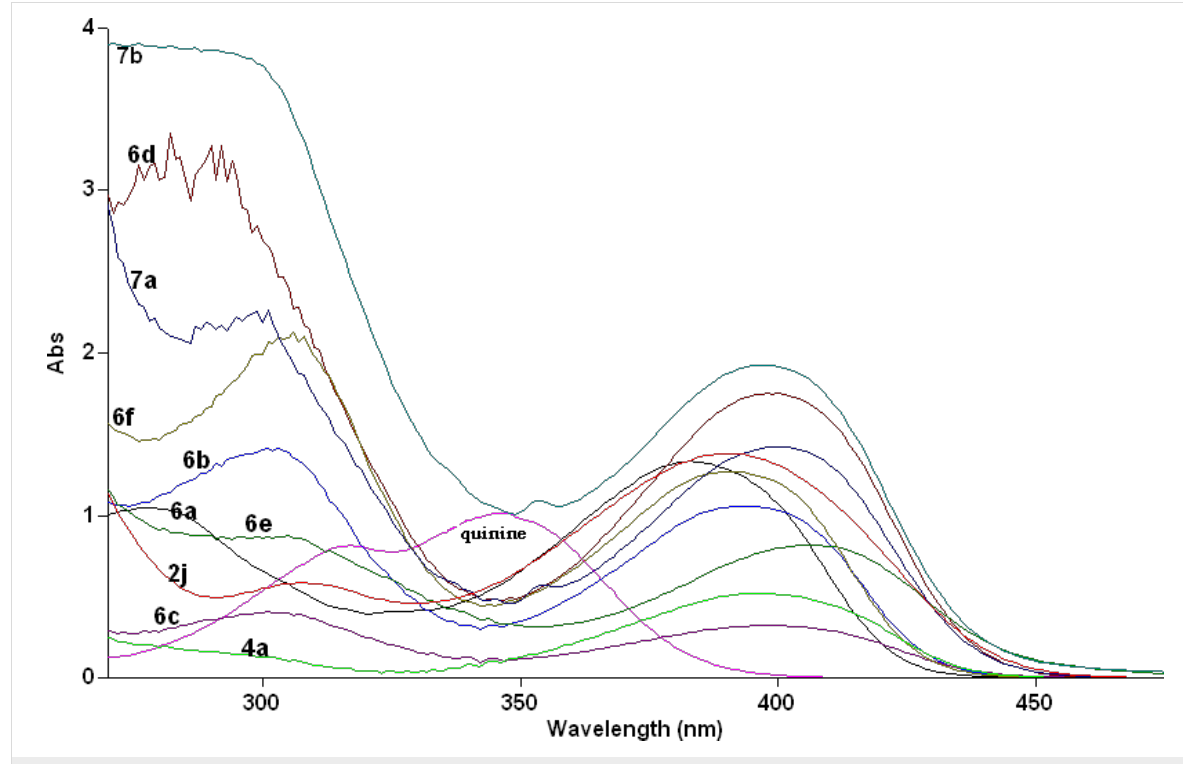
Figure 2: Absorption spectra of compounds 2j , 6a – f and 7a , b in acetonitrile (1 × 10 − 4 M).